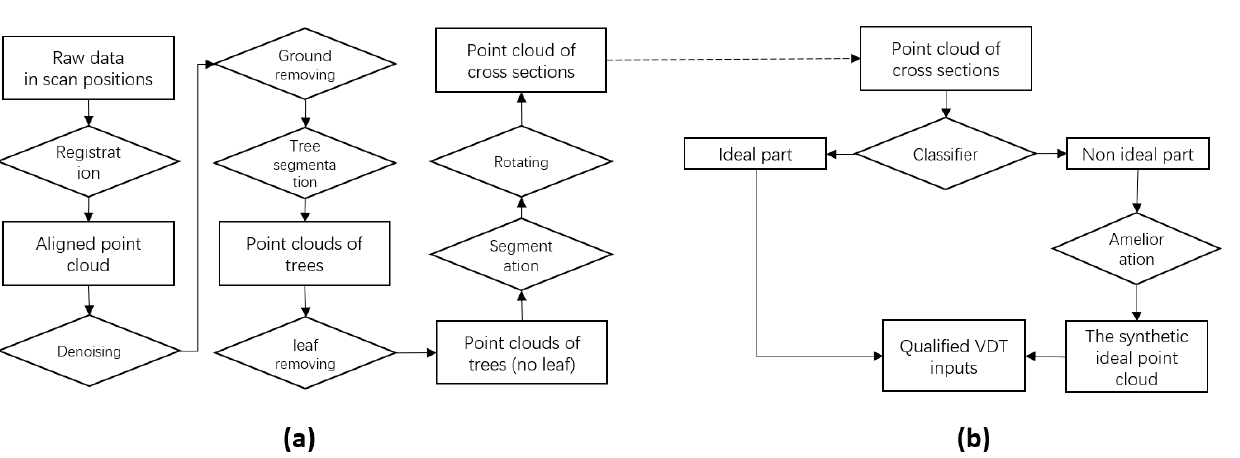
Figure 2. Two sections in data preprocessing: ( a ) conventional data preprocessing employed for LiDAR field scanning; ( b ) data preprocessing for VDT measurement. In the figure, VDT refers to virtual diameter tape.